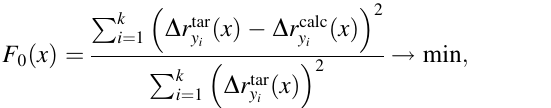
Wheel profile Fixed points Movable points